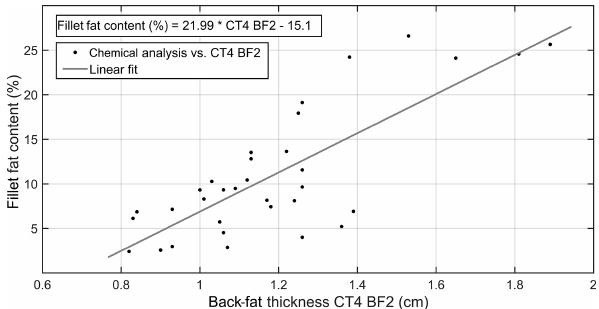
Figure 4. Correlation between fillet fat content determined by chemical analysis (%) and back-fat thickness CT4_BF2 (cm) de- termined by CT image ( R 2 = 0 . 62, n = 33, p < 0 .